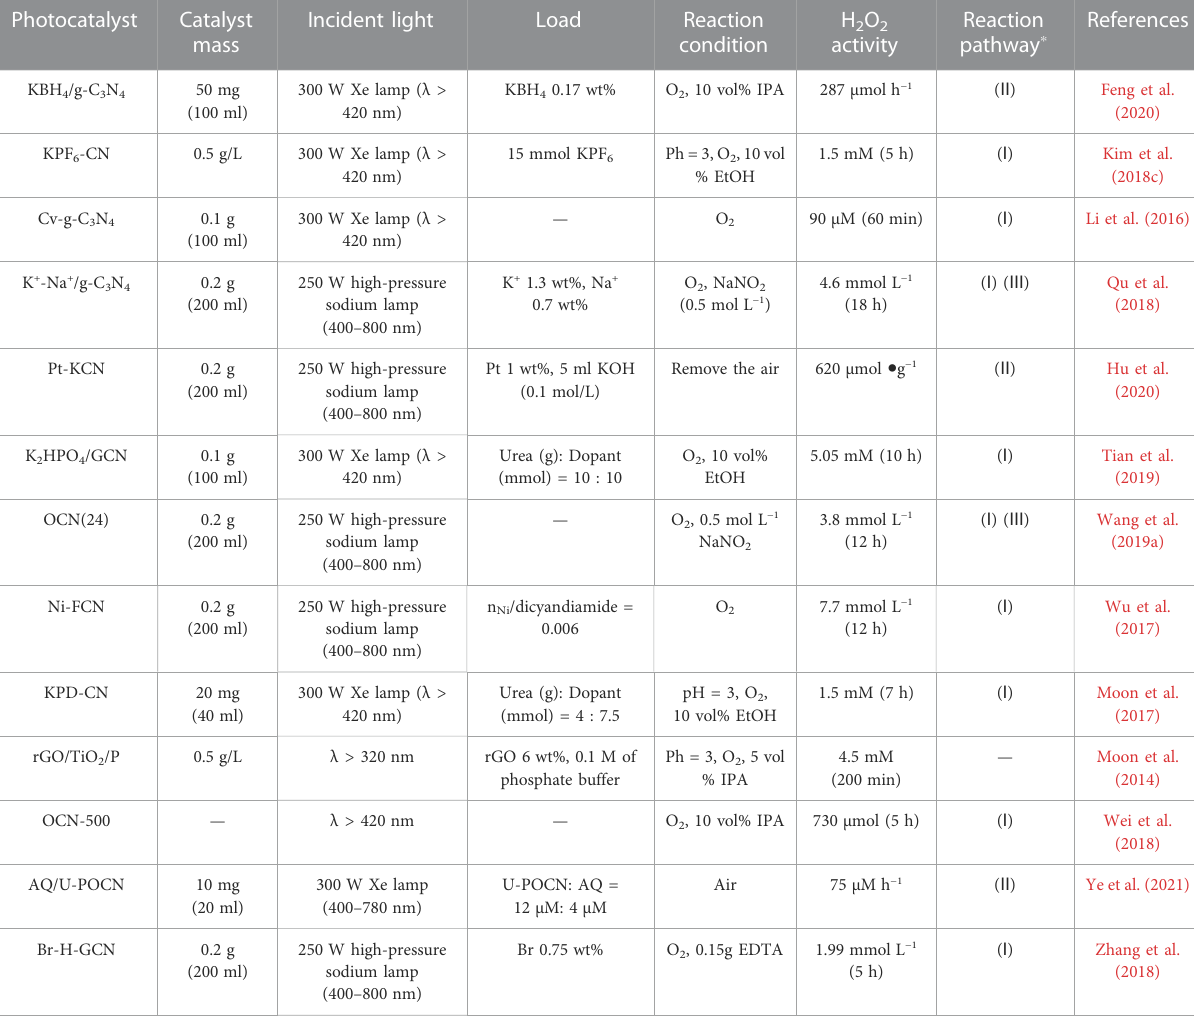
TABLE 3 Activities of photocatalysts with different types of ion